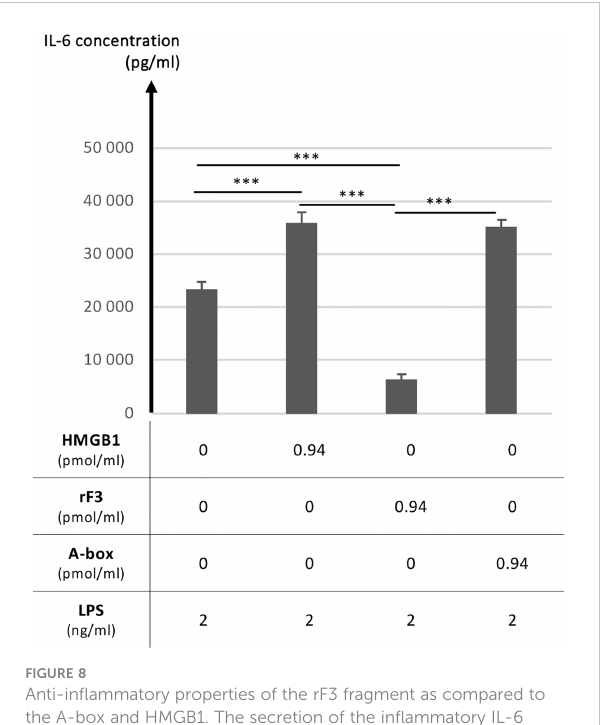
FIGURE 8 Anti-in fl ammatory properties of the rF3 fragment as compared to the A-box and HMGB1. The secretion of the in fl ammatory IL-6 cytokine is compared after stimulation by LPS at 1 or 2 ng/ml, alone or preincubated with HMGB1, rF3 or the A-box (see experimental details in section 2.5). A strong and signi fi cant reduction of IL-6 secretion is observed with rF3, as compared to LPS alone and in complex with HMGB1 and the A-box. Results are presented as mean +/- standard deviations (n=4). Control experiments showed the absence of IL-6 secretion in absence of LPS (Figure S3) and complementary experiments further illustrate the anti-in fl ammatory effect of rF3 as compared to the A-box (Figure S4). This data on rF3 is representative of two independent replicates performed at different concentrations. (***,